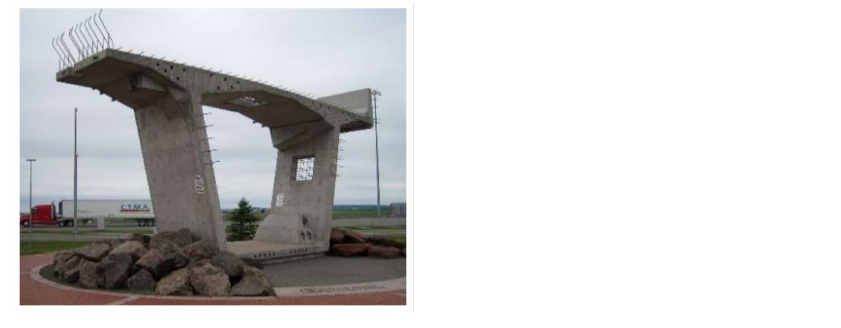
Figure 1. Display of a typical segment of the Confederation Bridge. (https://en.wikipedia.org/ wiki/Confederation_Bridge#/media/File:188_-_Piece_of_the_Confedration_Bridge.JPG, accessed on 23 June 2021).